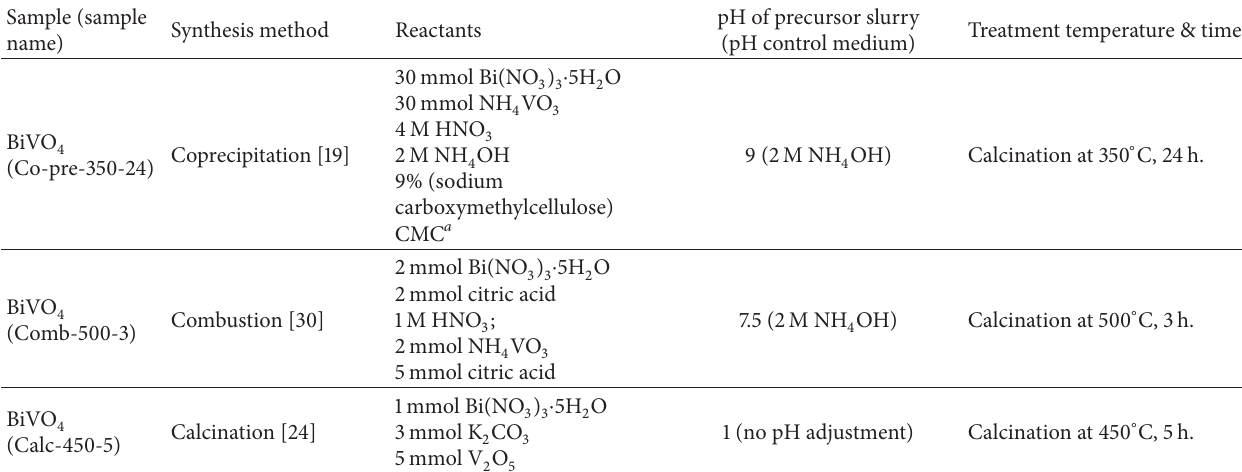
Table 2: Synthesis methods used and relevant parameters for the preparation of various BiVO 4 samples.